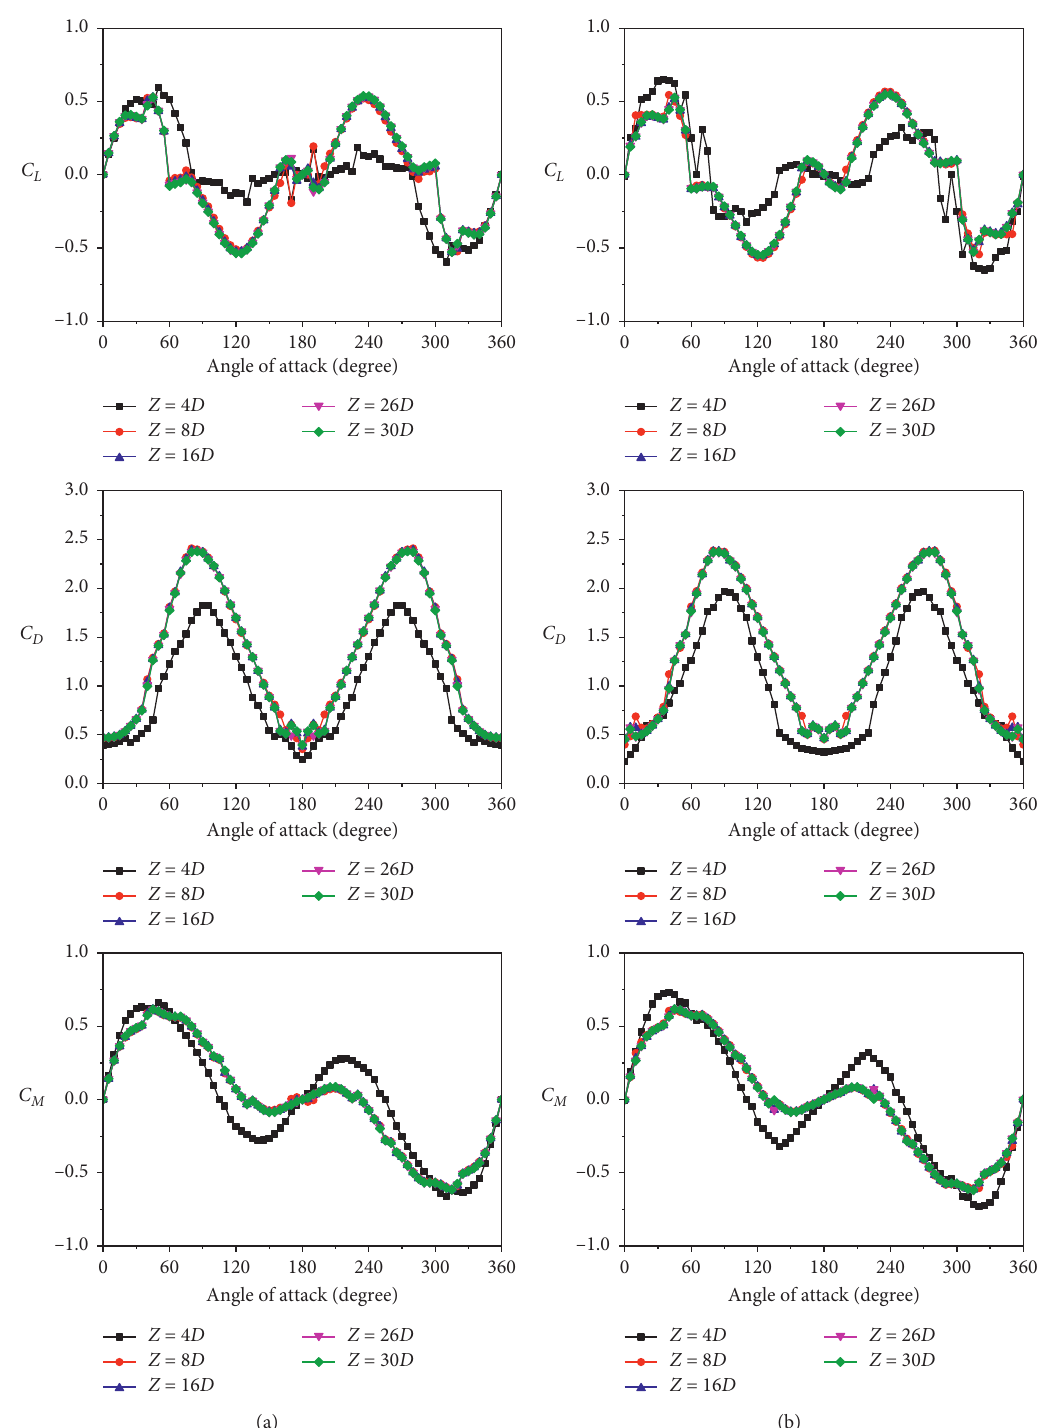
Figure 6: Aerodynamic coefficients of iced subconductors varying with wind attack angle Y � 0 D : (a) subconductor 1 and (b) subconductor